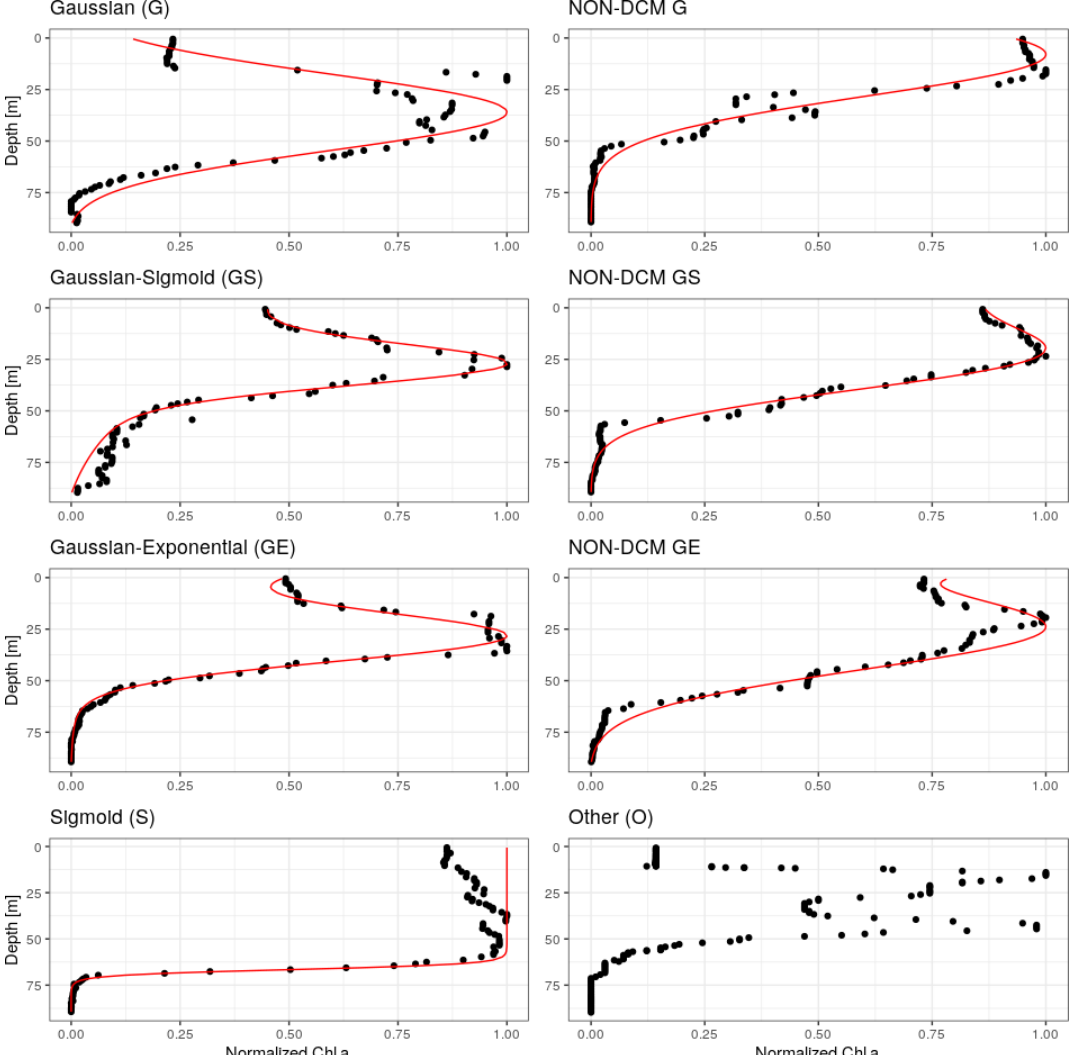
Figure 1. Examples of chl a profiles matched by each of the considered analytical forms. Right column: DCM profiles. Left column: non- DCM profiles discriminated by the ratio between surface and DCM chl a concentration (Sect. 3.2), and an example for the unmatched “other” category, which often corresponds to double chl a